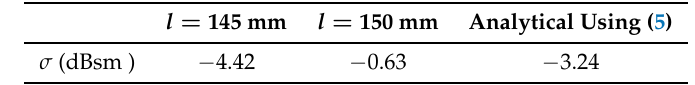
Table 1. The broadside ( θ i = 0 ◦ ) RCS of the retrodirective array for two different coaxial cable lengths. l = 145